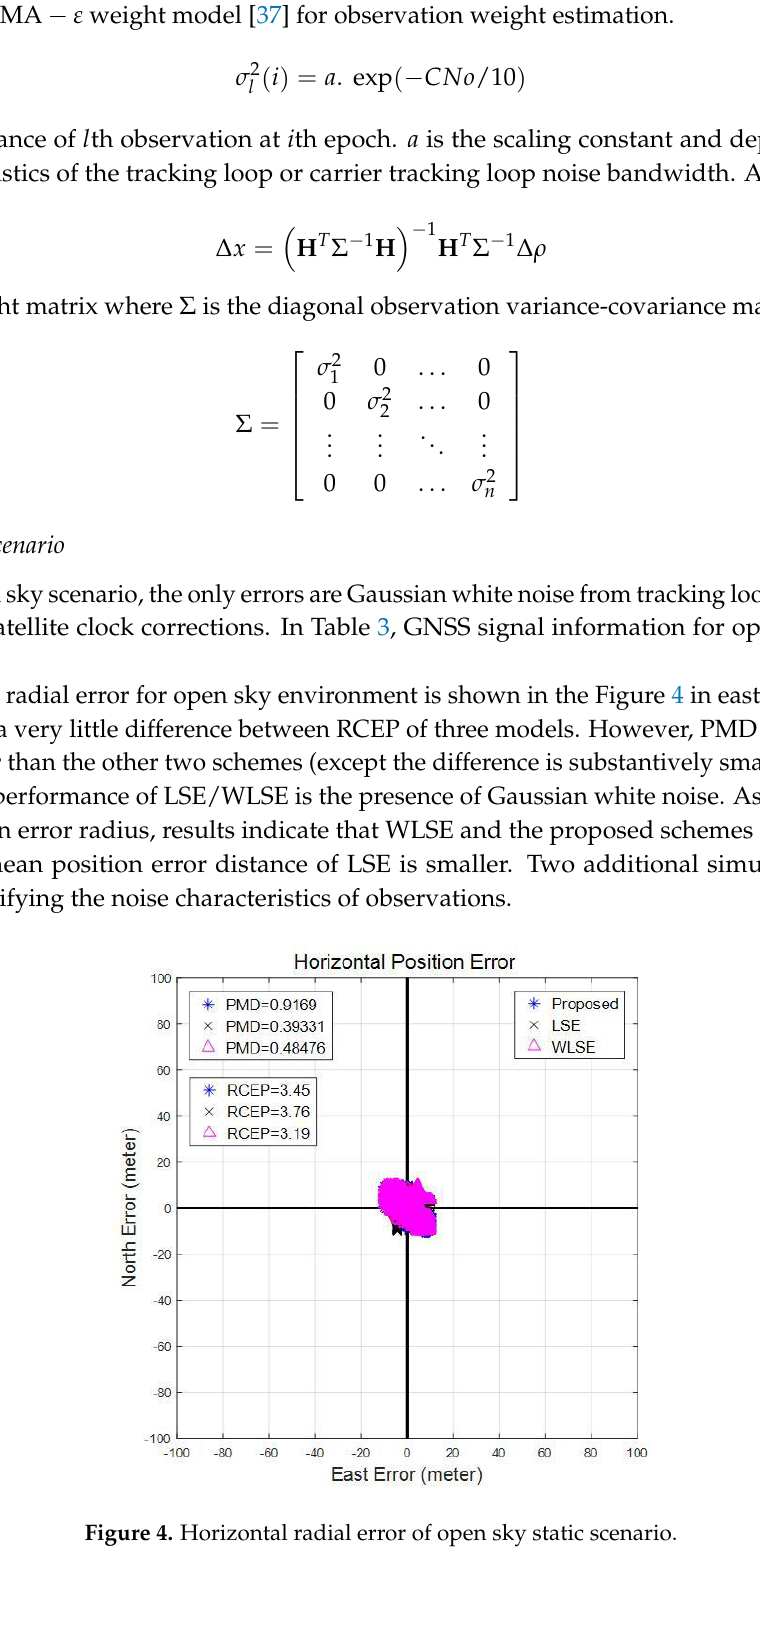
0 Figure 5. Horizontal radial error for emulated scenario 1.